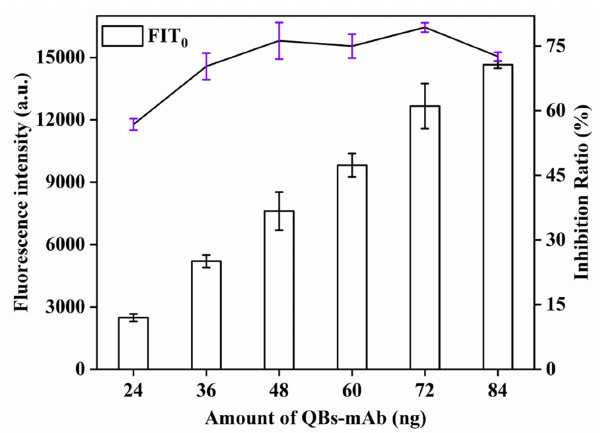
Figure 6. Optimization detection conditions of QBs-LFIA. Effects of amount of QBs-mAb.